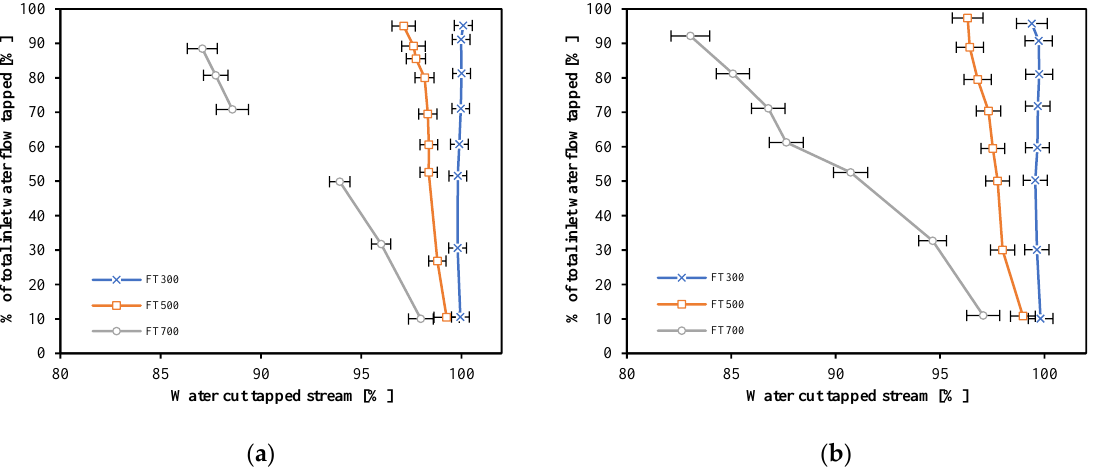
Figure 14. Drainage potential for ( a ) unspiked, ( b ) spiked oil and water at WC inlet 70%, total flow rate of 300, 500, and 700 L/min.